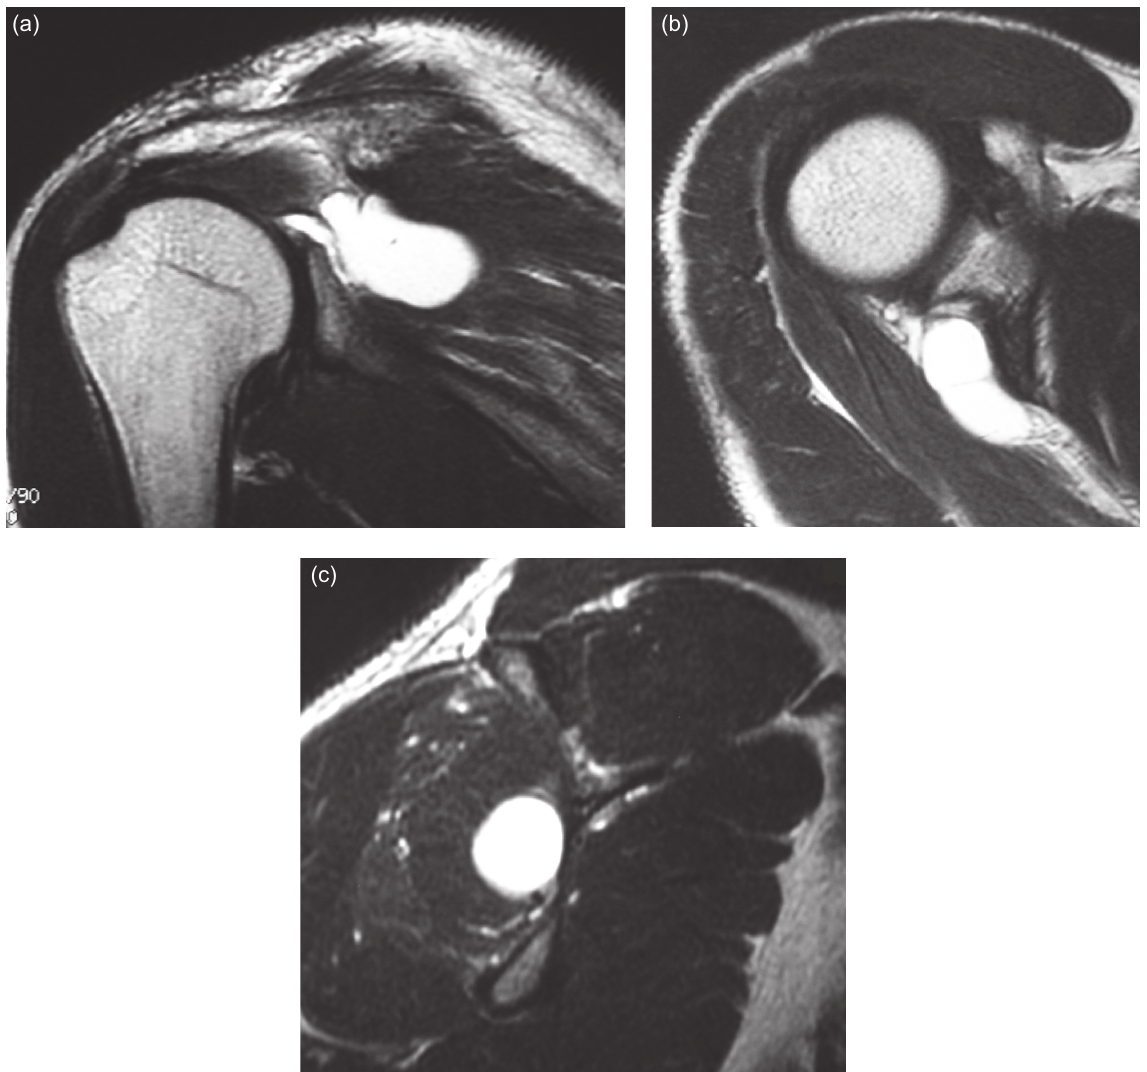
Figure 2. T2-weighted MRI scans of a left shoulder demonstrating a spinoglenoid cyst on the coronal image (a), the axial image (b), and the sagittal image (c). The sagittal image shows edema and atrophy of the infraspinatus muscle.